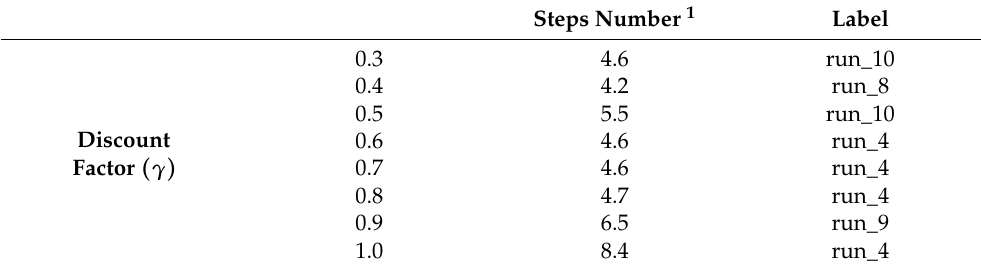
Table 7. Influence of the discount factor on the quality of agent training.